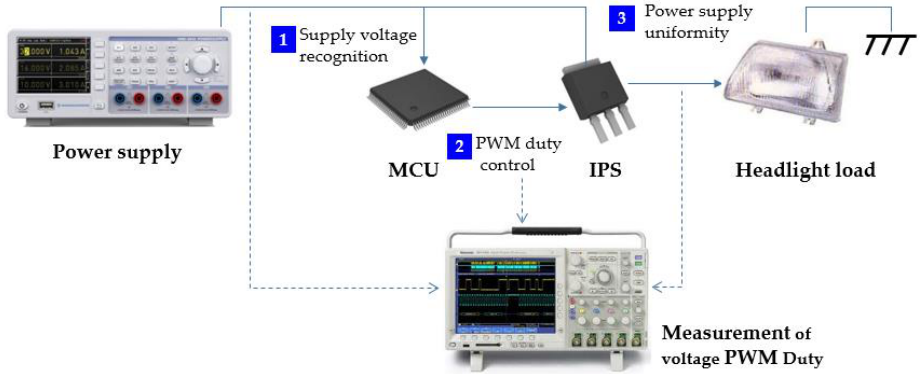
Figure 15. Schematic of the setup used to test the uniformity of the headlight power supply.